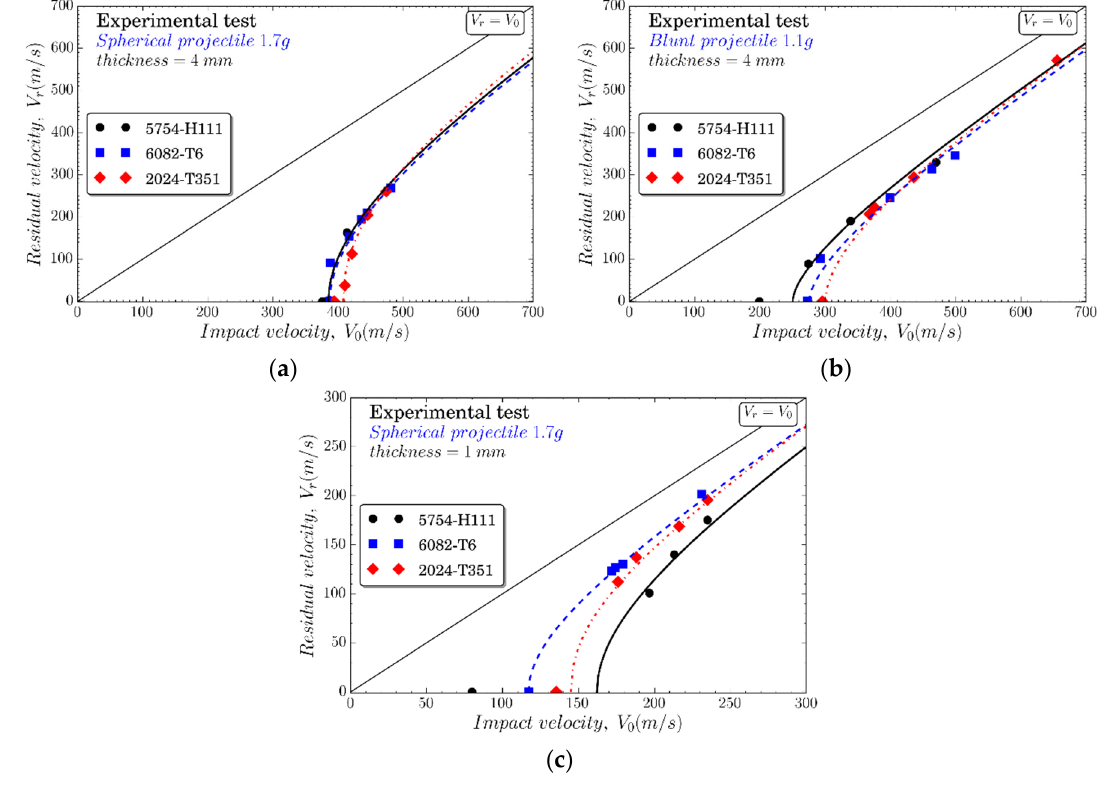
Figure 11. Comparison of residual velocity (cid:1848) (cid:3045) versus impact velocity (cid:1848) (cid:2868) for the three aluminum alloys studied: ( a ) spherical projectile and 4 mm thick plates; ( b ) blunt projectile and 4 mm thick plates; ( c ) spherical projectile and 1 mm thick plates.